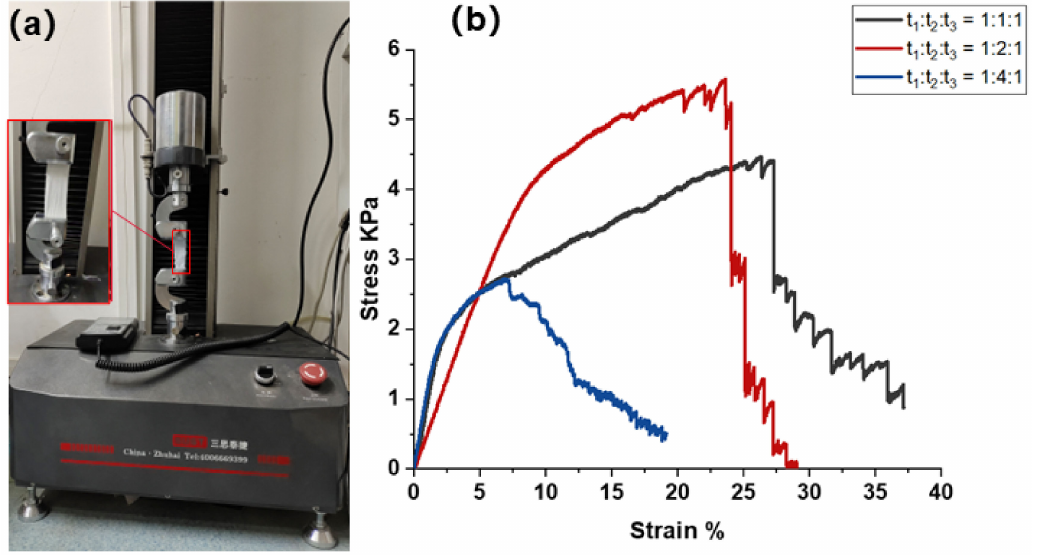
Figure 8. Microcomputer-controlled electronic universal testing machine and fiber stress-strain diagram of nanofiber membrane. ( a ) Microcomputer controlled electronic universal testing machine; ( b ) fiber stress-strain diagram of composite structure nanofiber